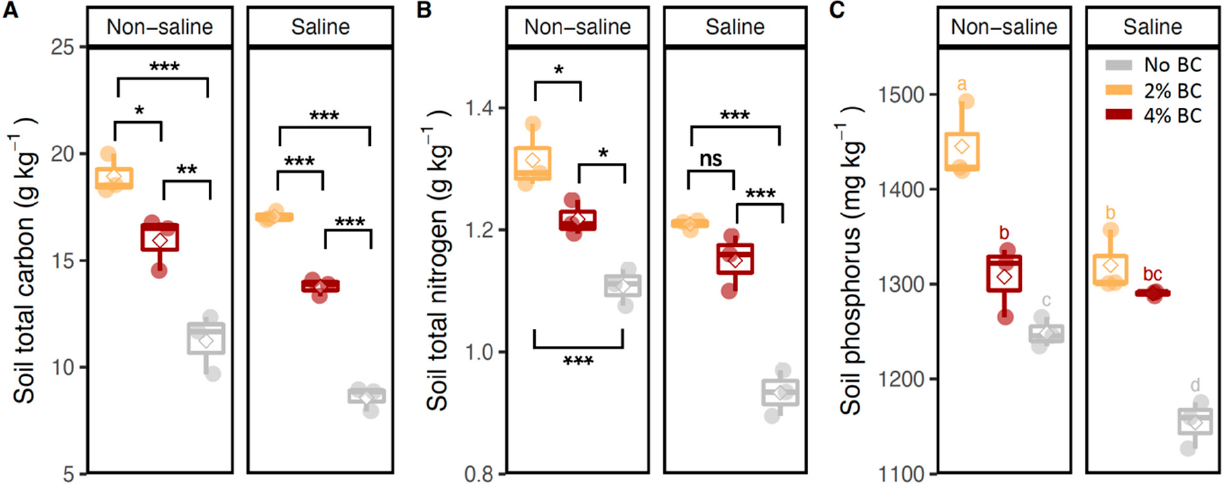
Figure 3. Effect of biochar application (2%, 4%) on soil total carbon ( A ), total nitrogen ( B ), and phosphorus ( C ) concentration in purslane planting systems under saline and non-saline conditions. The top and bottom of the box represent 75% and 25% quantiles, respectively. The bars of the box represent maximum and minimum values of observations. The line in the box represents the median. The dots represent every single observation. The rhombus in the box represents the mean. Codes (*: p < 0.05, ** p < 0.01, and *** p < 0.001; ns—not significant) in ( A , B ) indicates the significance of each paired comparison for the biochar factor. Letters within each column in ( C ) are significantly different based on Duncan’s test.